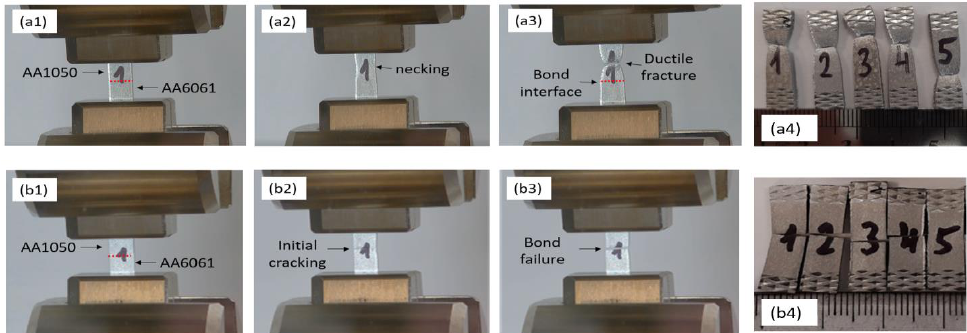
Table 6. Failure location of the tensile specimens for the first set of experiments.